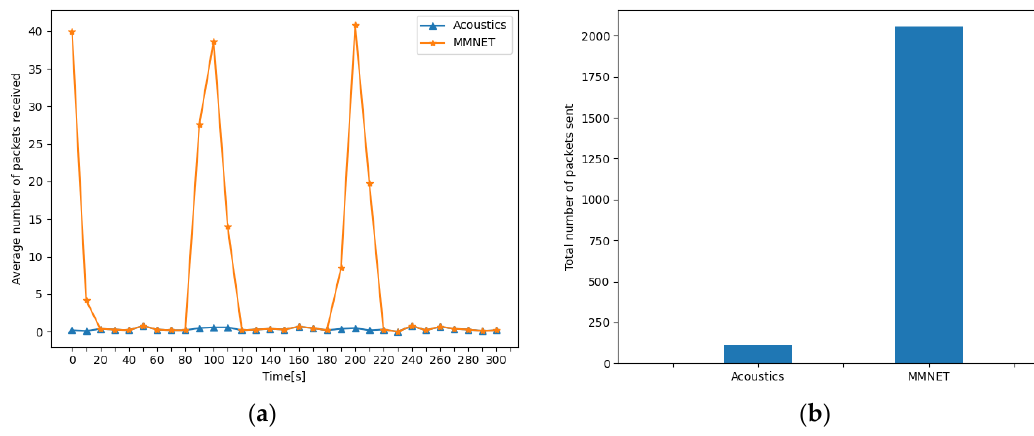
Figure 19. ( a ) Showing 10 s average packet transmission speed of MMNET and acoustic communication; ( b ) the total number of contracts in the whole simulation process.